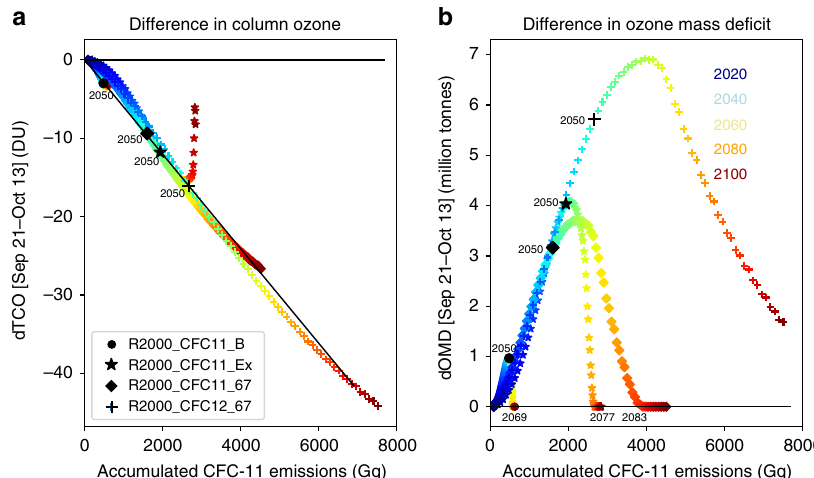
Fig. 6 Antarctic ozone depletion versus accumulated chlorine emissions. a The mean column ozone difference (DU) between run R2000 (2000 meteorology) and runs R2000_CFC11_B (with additional CFC-11 emissions from box model, circle), R2000_CFC11_67 (with constant CFC-11 emissions of 67 Gg yr − 1 , diamond) and R2000_CFC12_67 (with constant CFC-11 emissions of 67 Gg yr − 1 and CFC-12 emissions of 59 Gg yr − 1 , + symbol) in regions 60 o S – 90 o S for the period September 21 – October 13 (corresponding to the time period for the ozone mass de fi cit metric in Fig. 3) is plotted against accumulated additional equivalent CFC-11 emissions (Gg). Also shown are the results for simulation R2000_CFC11_Ex (star, see Supplementary Information). The colour shading indicates the year for each data point; the points for 2050 are plotted in black. The slope of best- fi t line through the 2050 data points is 0.6 DU/100 Gg CFC-11. b Difference in estimated ozone mass de fi cit (million tons) versus accumulated equivalent CFC-11 emissions for the same simulations as panel ( a